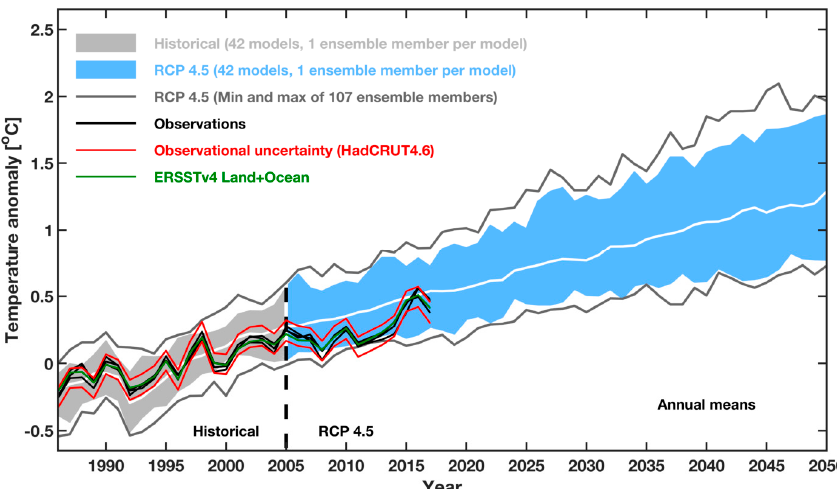
Figure 1. Modeled and observed annual-mean global-mean surface temperature relative to 1986–2005 mean. Adapted from IPCC AR5 Figure 11.9 and updated to the end of 2017. The observations from HadCRUT4.3 [4], GISTEMP [5] and ERA-Interim [6] are in black lines and NCDC (ERSST.v4 land + ocean) is in green. GISTEMP uses ERSST.v4 SST [2] for its sea-surface temperature (SST). The red line is the one standard deviation of combined observational uncertainty due to measurement, sampling and coverage. The shading shows the 5–95% range of 42 models, with grey for the historical simulation and blue for the projection under the RCP4.5 scenario. The white line is for the multi-model mean. The grey curves are the maximum and minimum envelopes of 107 ensemble members.